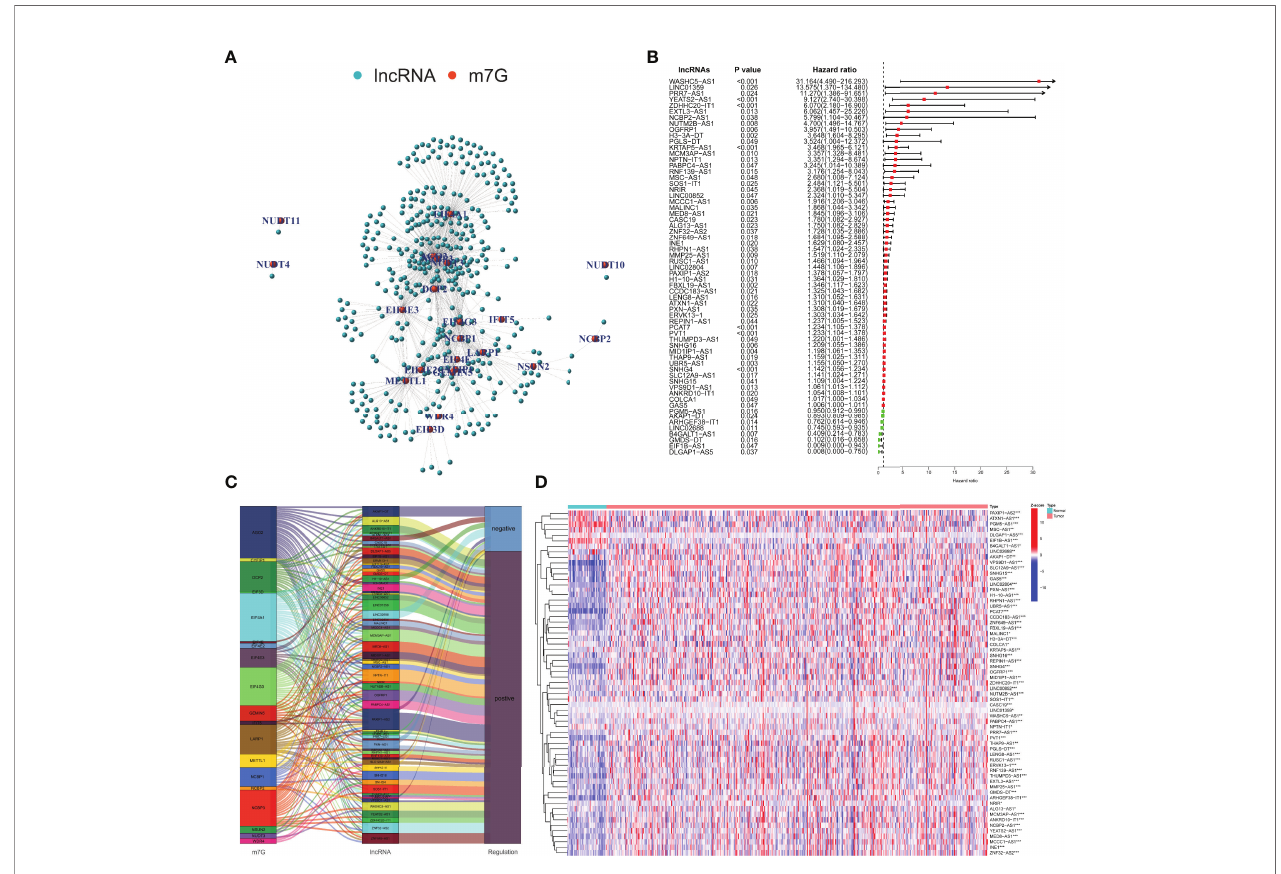
FIGURE 2 | Identi fi cation and evaluation of the m7G-related lncRNAs. (A) Co-expression network of m7G-related mRNAs and lncRNAs. (B) Selection of prognosis- related lncRNAs with univariate Cox regression analysis. (C) The correlation between m7G-related mRNAs and lncRNAs with the Sankey diagram. (D) Expression difference analysis of the m7G-related lncRNAs. m7G, 7-methylguanosine; lncRNAs, long non-coding RNAs. *p < 0.05; **p < 0.01; ***p <